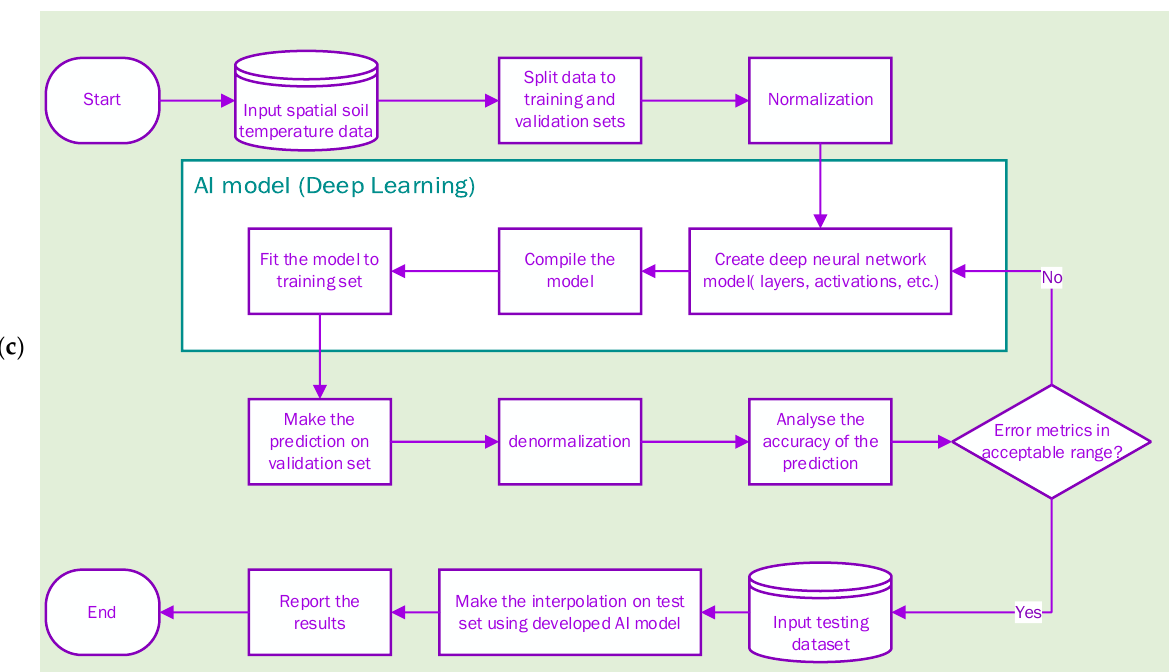
Figure 4. Algorithm of the interpolation models: ( a ) spline method ( b ) RBFN ( c ) deep learning.